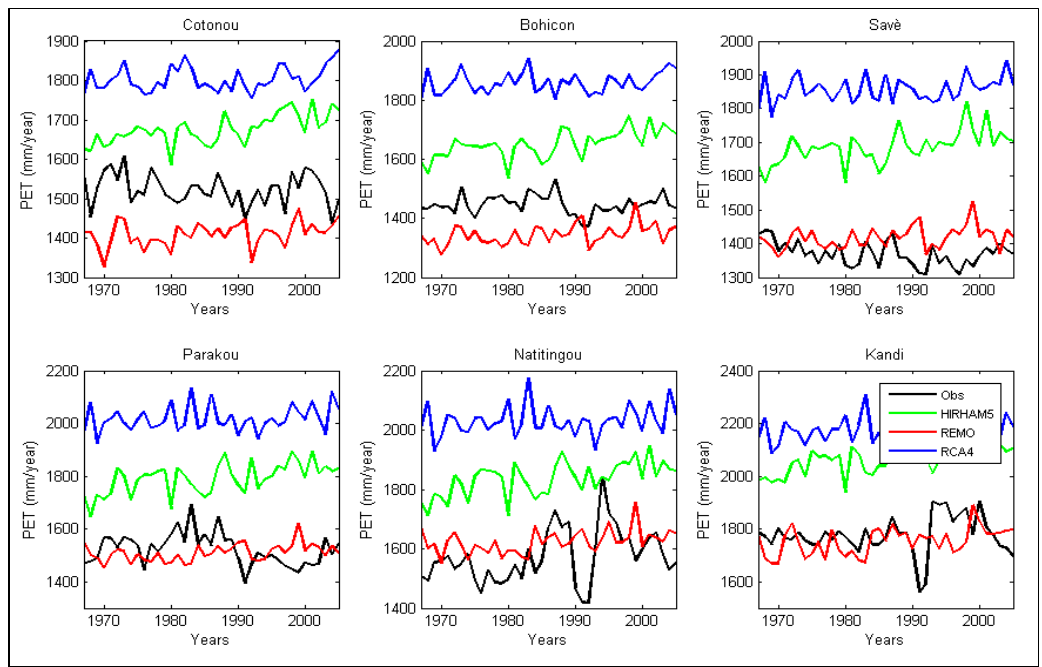
Figure 3. Observed and simulated (no bias corrected) annual PET.